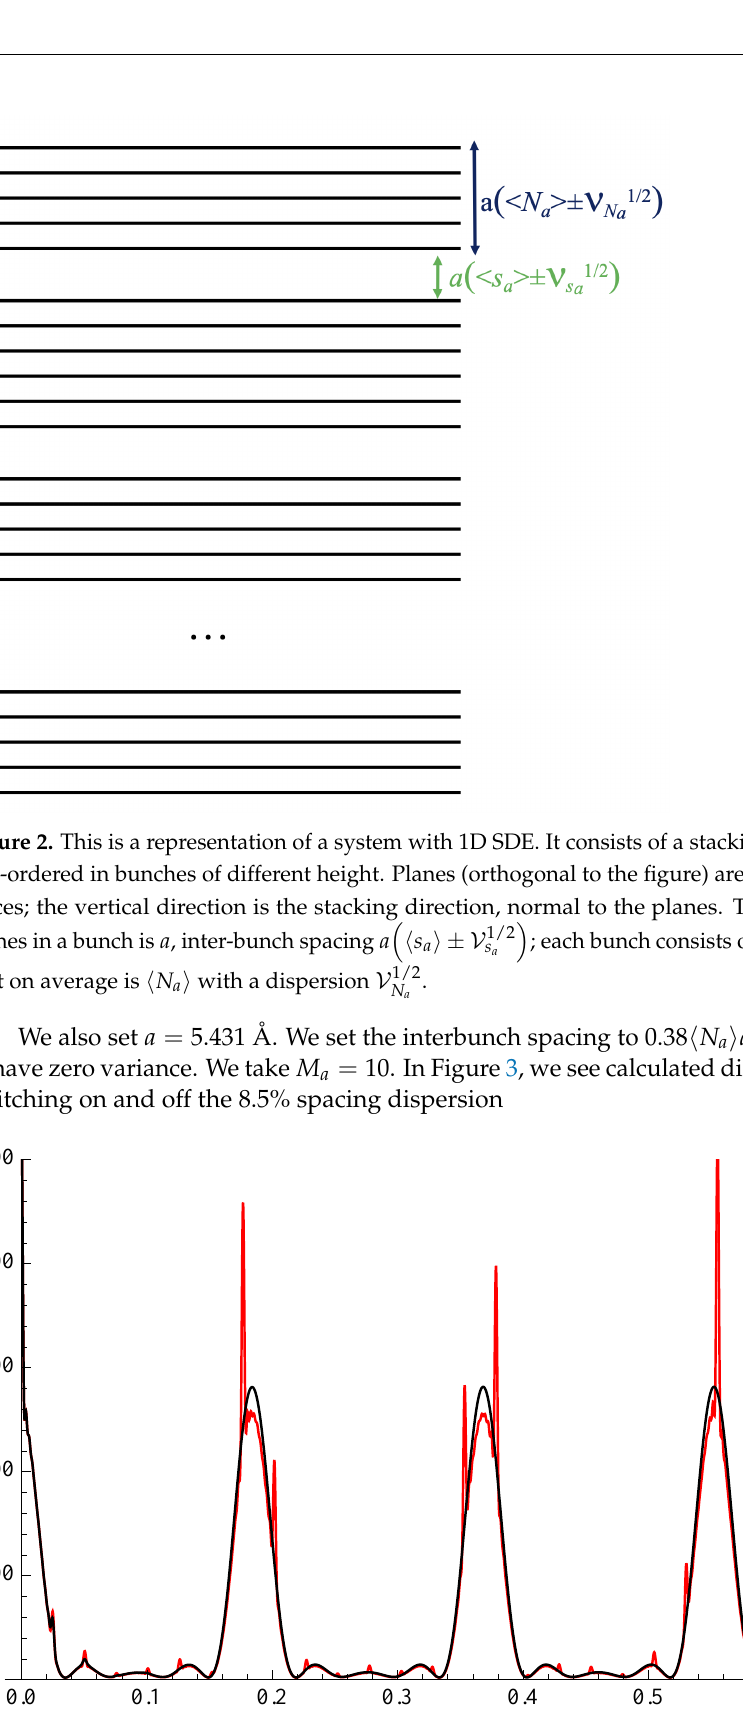
Figure 3. Plane bunch sequence 1D diffraction pattern: Red—calculation with zero spacing dispersion; Black—including 8.5% spacing dispersion as from the text. The 8.5% dispersion destroys the sharp small peaks (SL interference) except in the small-angle